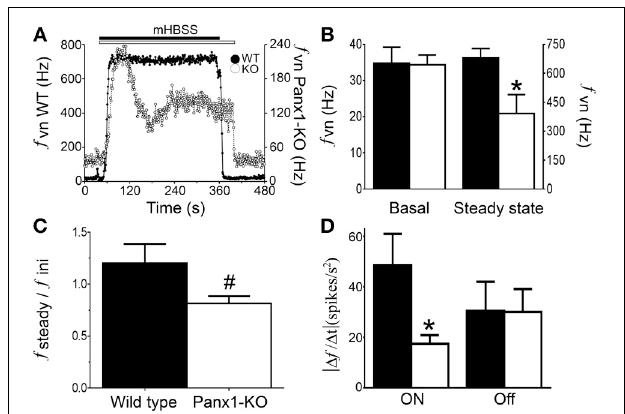
FIGURE 6 | NPJcs from Panx1 knock-out mice are less responsive to mHBSS. NPJcs were obtained from wild type (WT) and Panx1 knock-out (Panx1-KO) mice and the mHBSS effect on the vagus nerve activity was tested. (A) Representative records showing changes in f VN induced by mHBSS in NPJcs of WT (filled circles; left Y-axis) and Panx1-KO (empty circles; right Y-axis) mice. Bars on top of the recordings indicate the duration of each stimulus. (B) f VN of NPJcs of WT (filled bar, n = 8) and Panx1-KO mice (empty bar, n = 9) recorded when the NPJcs were superfused with HBSS (Basal; left Y-axis) or mHBSS (Steady state; right Y-axis). (C) Graph showing the ratio between the f VN in steady state divided by the maximal f VN reached after mHBSS superfusion (see Figure 3 for definition). (D) Graph showing the rate (in absolute value) of the initial changes induced by mHBSS (ON) or the rate of changes when mHBSS was changed to HBSS (OFF) in NPJcs of WT (filled bar, n = 8) and Panx1-KO mice (empty bar, n = 9). Statistical significance; P < 0 . 05 with respect to WT. # Because these data are unrelated and not normally distributed, we used the Mann-Whitney test; ∗ Student’s t